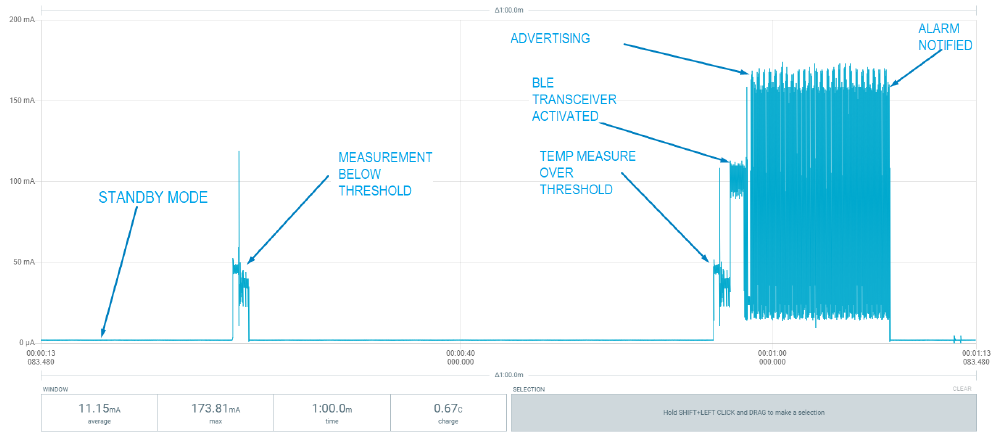
Figure 9. Full communication alarm process.